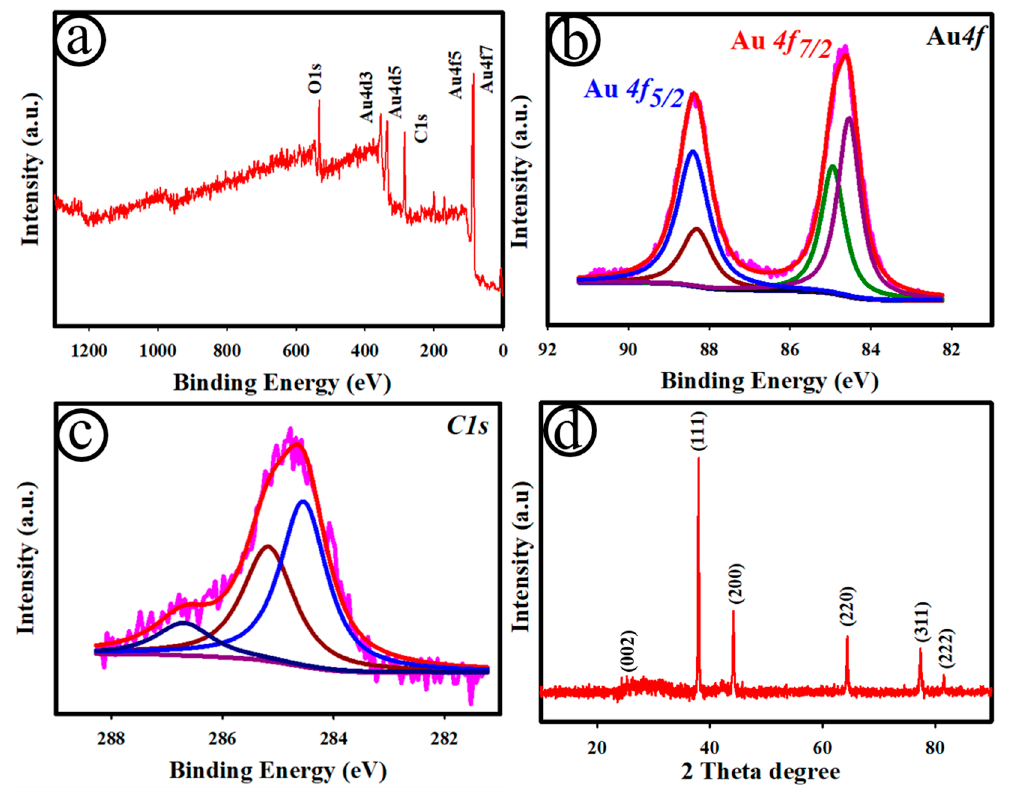
Figure 3. XPS survey spectra ( a ), and Au 4f ( b ) and C 1s ( c ) regions of the AuNC@AuDS|CF microelectrode; XRD pattern of the AuNC@AuDS|CF microelectrode ( d ).